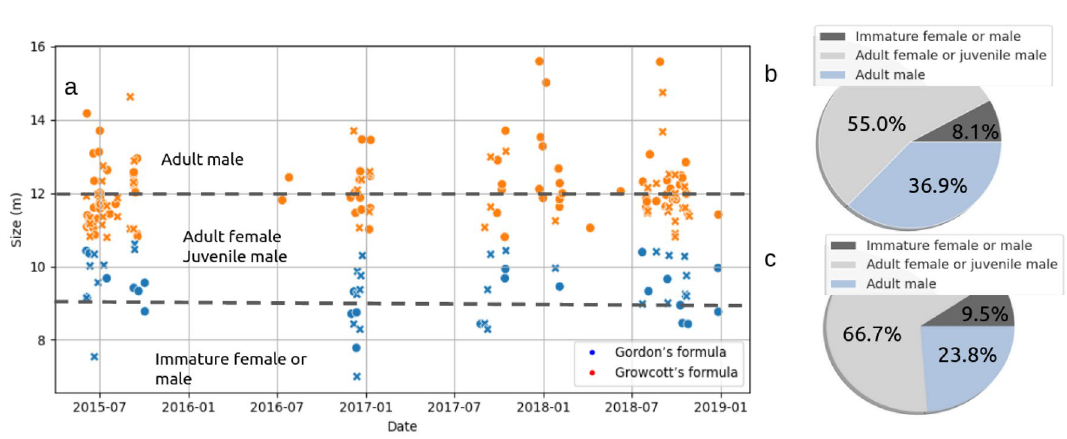
Figure 4. Left: size of the sperm whales over the 3 years of recordings for passages with one individual (dot) and two individuals (cross). Right: the proportion of each size categories for passage with one individual ( b ), and two individuals ( c